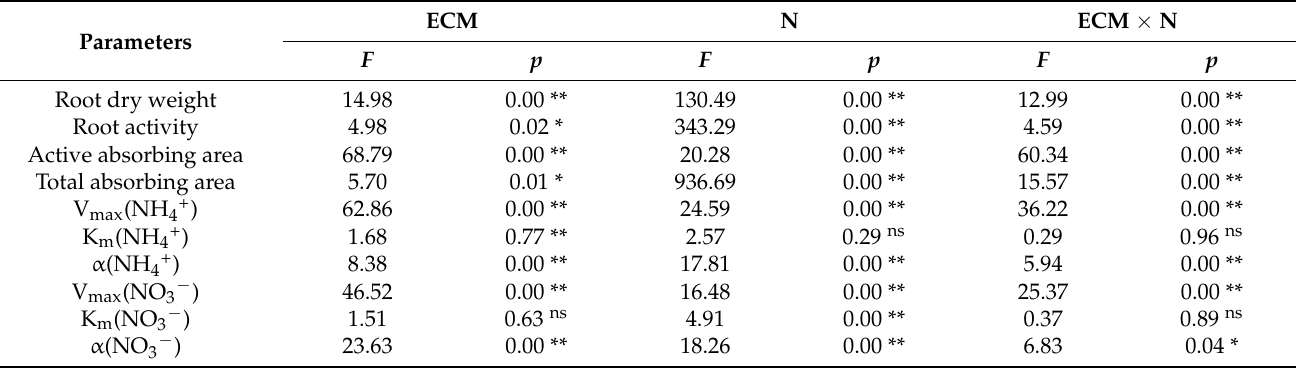
Table 3. Effects of nitrogen treatment (N), ECM treatment (ECM), and N × ECM on the parameters of Pinus massoniana